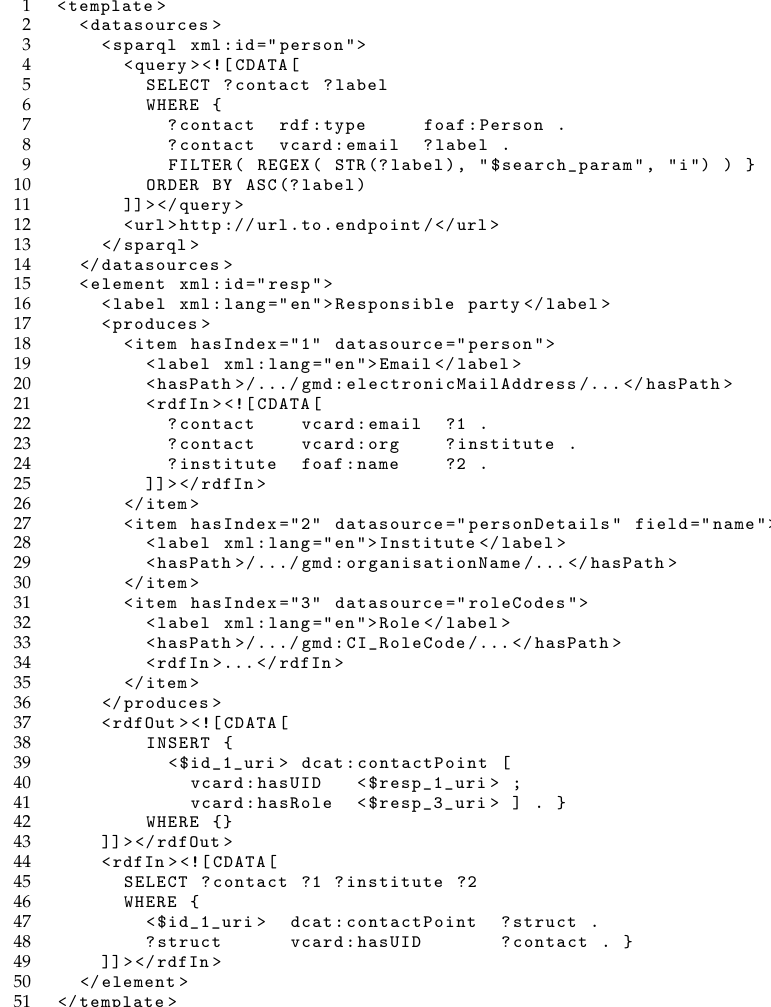
Listing 1. Code fragment from the INSPIRE